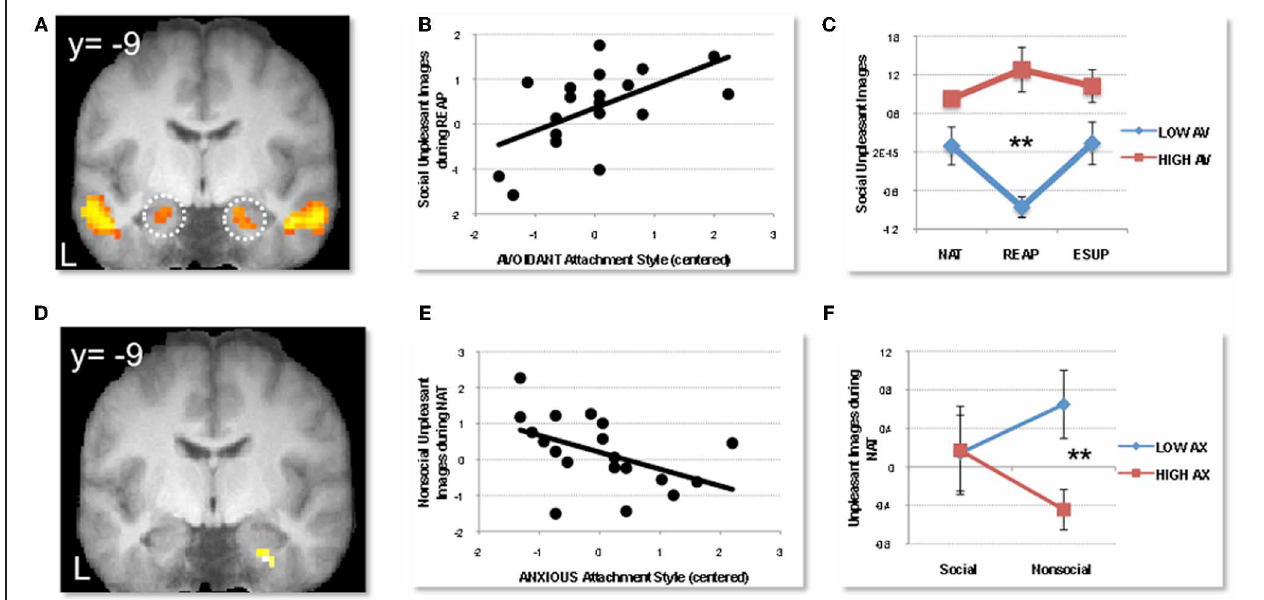
FIGURE 3 | Modulation of social emotion perception and regulation by adult attachment style. Adapted from Vrticka et al. (2012a). (A) Bilateral amygdala activation to social (versus nonsocial) emotional scenes perception, regardless of valence (positive or negative) and task. (B) Positive correlation between avoidant attachment (AV) scores and activity in left amygdala for social negative images during reappraisal (averaged across voxels). (C) Median split illustrating data for high (red; N = 5) versus low (blue; N = 8) avoidantly attached participants in left amygdala, showing a decrease in activity to social negative images during reappraisal for the low but not high avoidant group ( ∗∗ indicate the differential response accounting for significant effects in the correlation analysis). (D) Right amygdala activation to negative